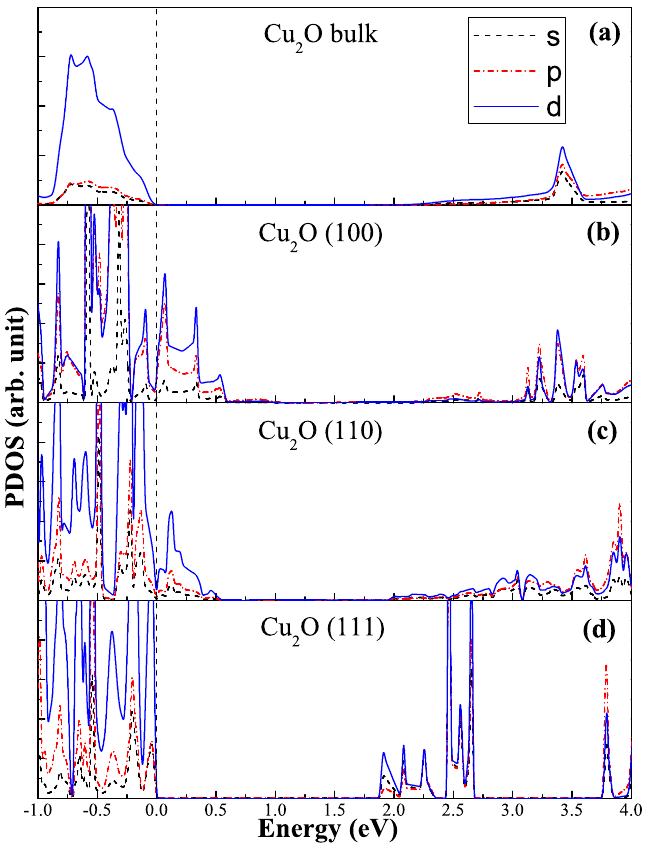
Figure 2. The projected density of states (PDOS) for Cu 2 O low-index